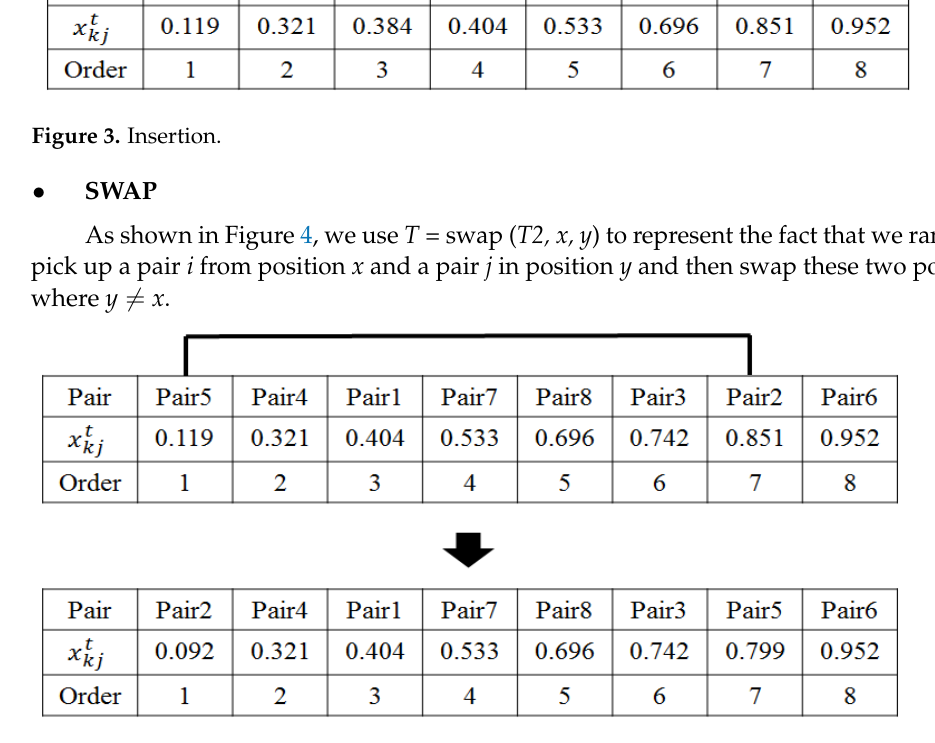
Figure 4. Figure 4. Swap.